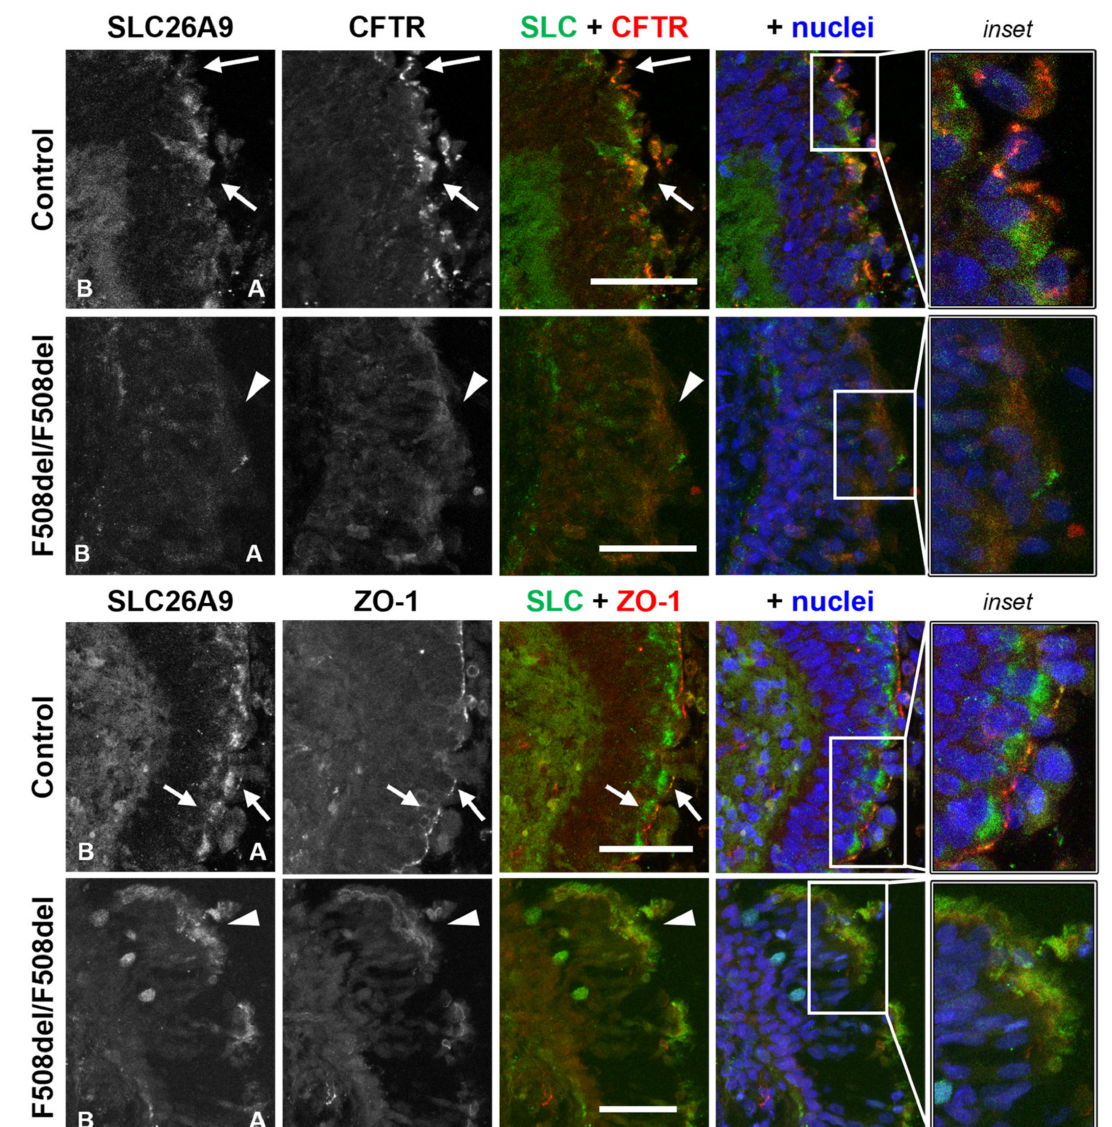
Figure 1. SLC26A9 has a sharp apical TJ-like localization in control lung but a faint (apical) cytoplasmic localization in F508del/F508del lung. Representative images of native human bronchial tissue (Control and F508del/F508del) immunos- tained for SLC26A9, CFTR and ZO-1. Nuclei are depicted in blue, SLC26A9 in green and CFTR/ZO1 in red. Scale bars represent 50 µ m. Images are displayed as maximum image projections (MIPs). Apical and basal (A and B, respectively) sides of the epithelia are identified. SLC26A9 co-localizes with CFTR and ZO-1, whether they show apical localization (arrows, control) or diffuse cytoplasmic expression (arrowheads). Close-ups of the areas identified with arrows/arrowheads (insets) are shown on the right-hand side. The stained tissues display secondary/tertiary bronchi and were as similar as possible for comparison. Areas of extensive shedding/remodeling in CF tissue were avoided, and areas of intact epithelia preferred ( n = 3